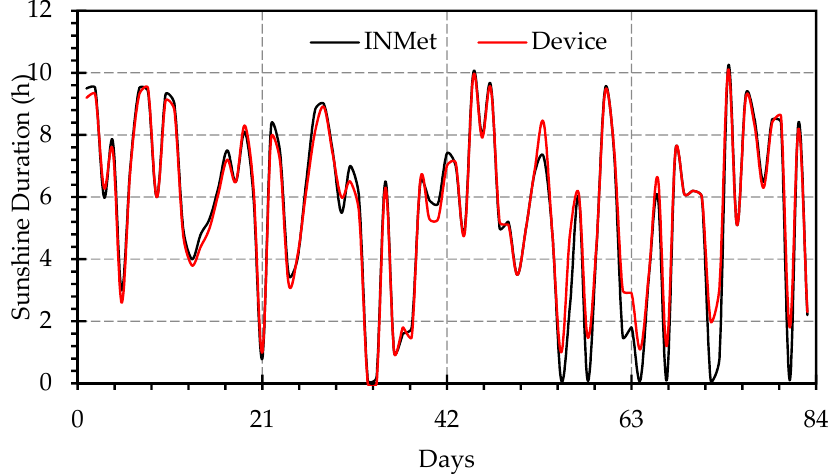
Figure 12. Comparison between prototype response (red line) and official data (black line).